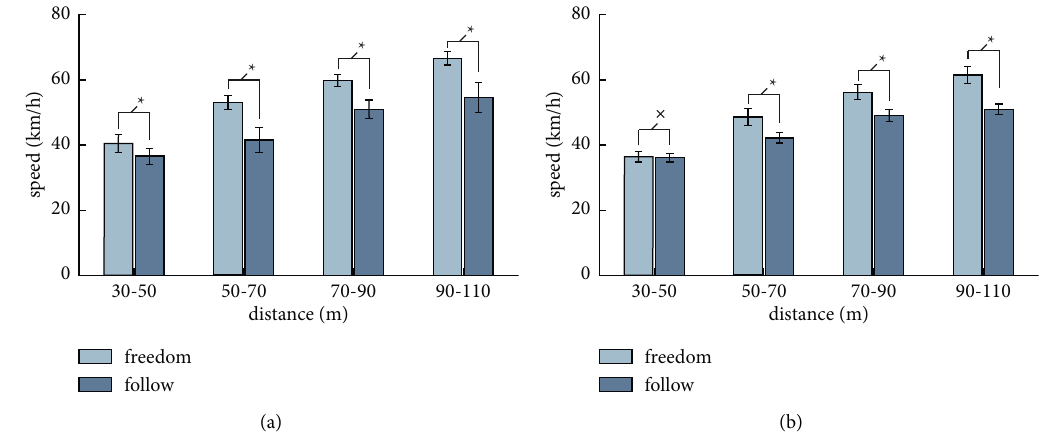
Figure 10: ANOVA results for traffic state on the second approach speed. (a) Low density; (b) high density.